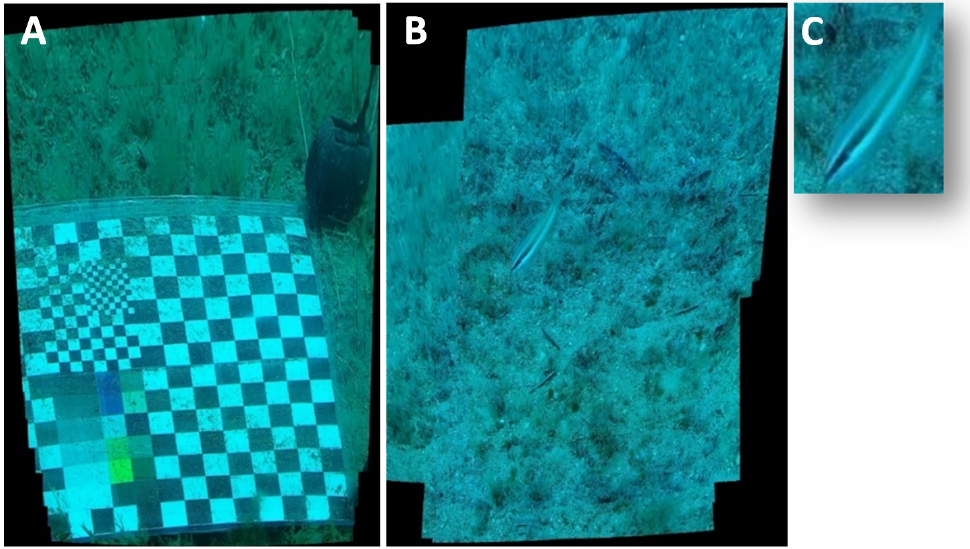
Figure 14. Checkerboard photo-mosaic generated after the calibration ( A ) and photo-mosaic ( B ) with an enlarged vision of a detected fish (( C ); SPECIES).